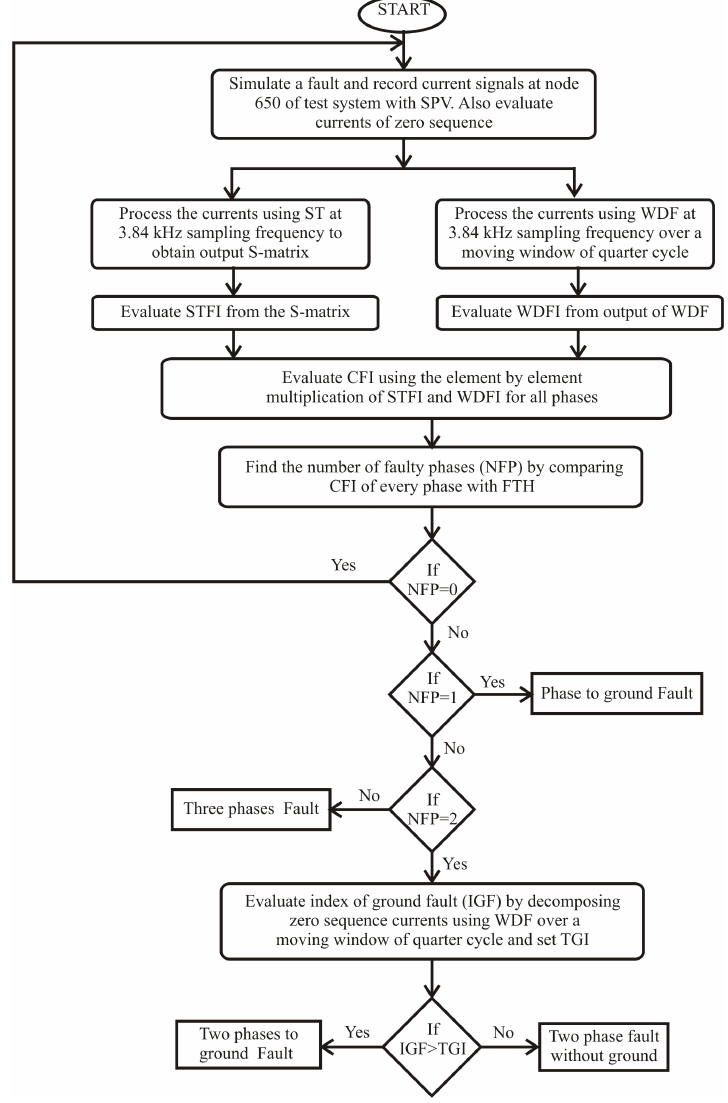
Figure 1. Fault recognition